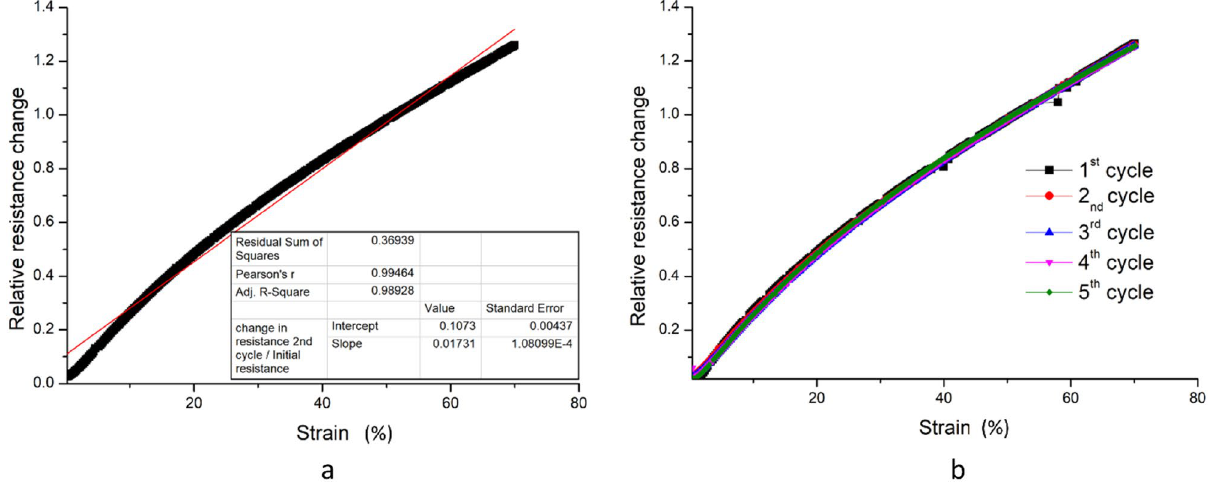
Figure 4. Normalised resistance change of the sensor for 70% strain ( a ) and demonstration of reproducibility of the sensor measurements ( b